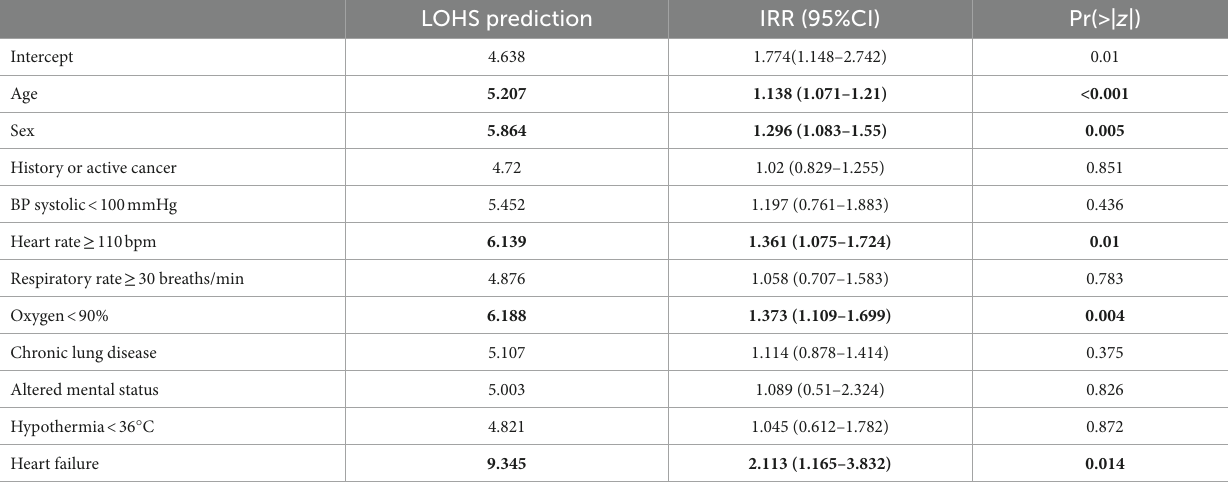
TABLE A1 Multivariable zero-truncated negative binomial regression model for length of hospital stay (LOHS) estimation in pulmonary embolism survivors with pulmonary embolism severity index (PESI) items separately assessed ( n = 234). LOHS prediction IRR (95%CI) Pr(>| z |) Intercept